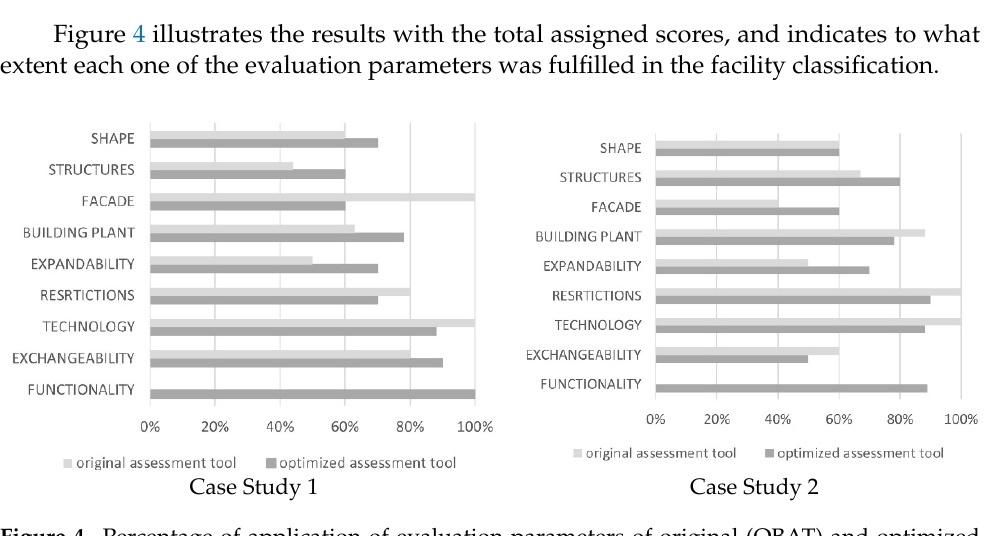
Figure 4. Percentage of application of evaluation parameters of original (OBAT) and optimized assessment tools (OFAT)